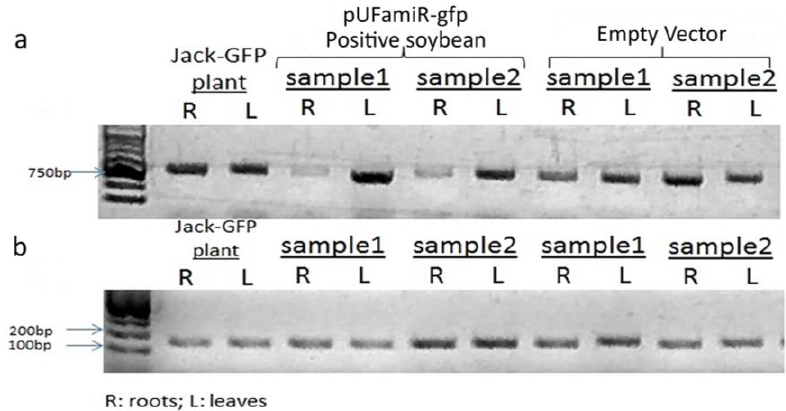
Figure 3. RT-PCR analysis of typical transgenic root samples to confirm the expression level of sGFP mRNAs. ( a ) The GFP expression was tested on the root tissue and leaf tissue separated with the positive and control transgenic hairy roots, independently. Control soybean was inoculated by K599 with pUF empty vector. The Jack–GFP transgenic plants were used as a positive control; ( b ) The expression level of the Rib gene was monitored in parallel from the same samples as a control.